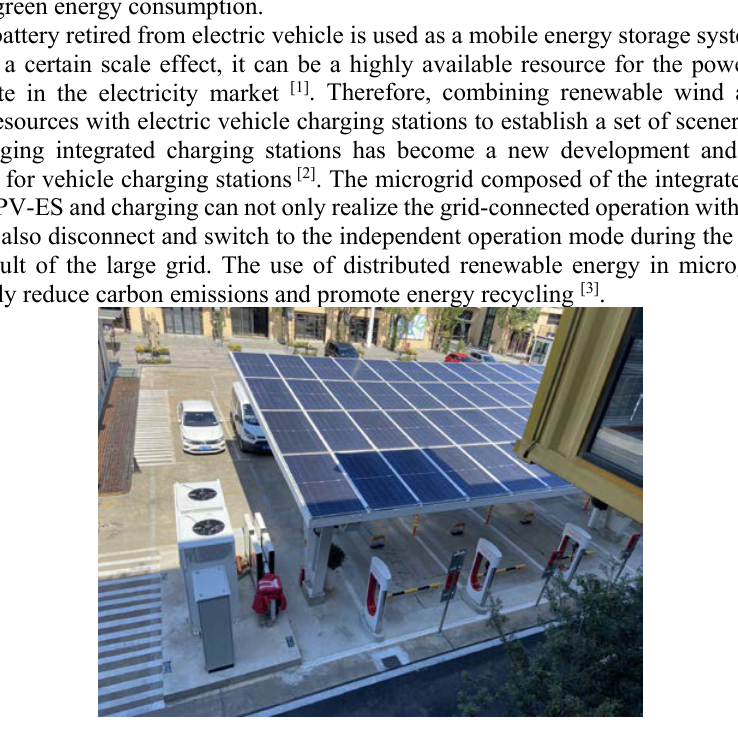
Fig. 2. Tesla PV-ES station in